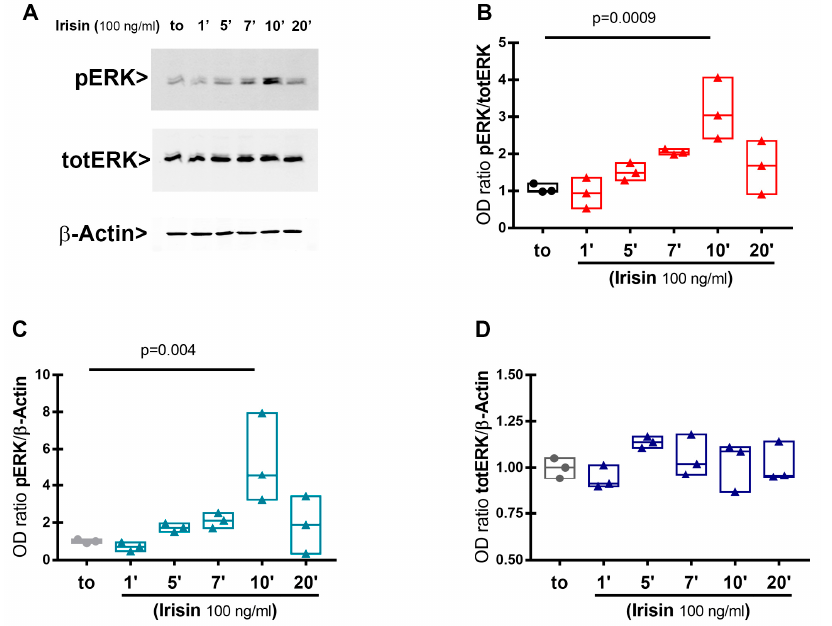
Figure 1. Irisin effect on ERK phosphorylation (pERK) in HACs cultures. HACs were treated with Irisin for the indicated time points. Representative image of phosphorylated ERK, Total ERK, and β -Actin levels in cell lysates analyzed by Western blotting ( A ). Expression levels of pERK, TotalERK, and β -Actin were measured with corresponding densitometric quantification. Densitometric analysis of the related bands was expressed as relative optical density of the bands, normalized to TotalERK ( B ) and β -Actin ( C ). Boxplot showing the normalization of TotalERK to β -Actin ( D ). Data are presented as boxplots with median and interquartile